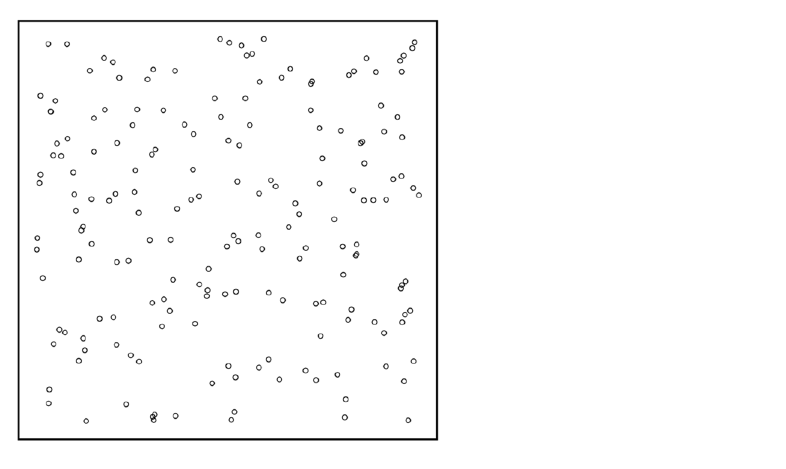
Figure 2. An example of the picture presented in Experiment 1 (random dots estimation task). This is the figure for Question 1 (correct answer: 183).